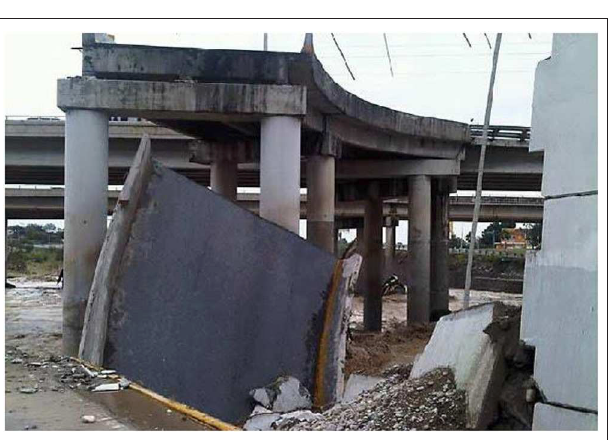
FIGURE 11 | Severe damage to bridge over Constitucion-Lopez Mateos Avenue. Courtesy from El Norte.